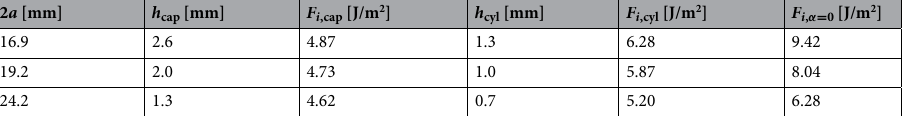
Table 1. Calculated values of the inactivation characteristic fluence, F i , when fitting the experimental values obtained for three drops, to the cylindrical, spherical cap, and non absorbing ( α = 0 ) models. The volume for all the drops is the same V = 300 µ